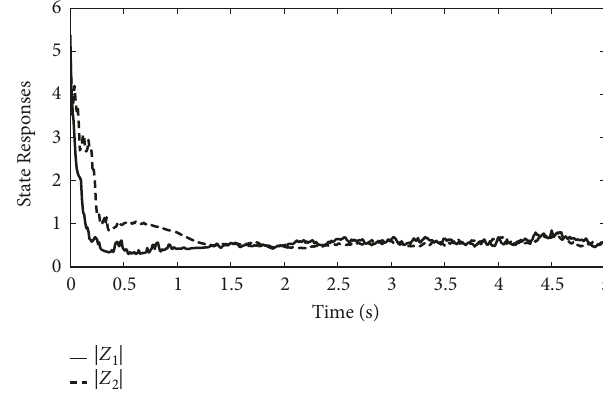
Figure 7: State module curves of (52) with stochastic